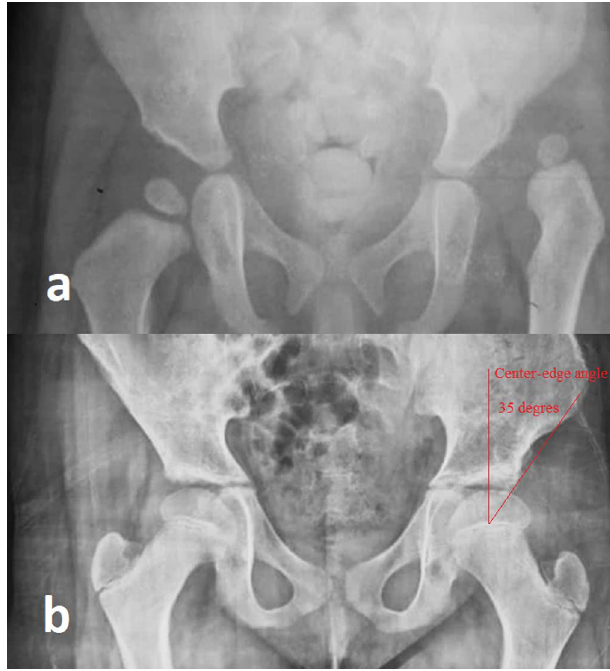
Figure 1. (a) Preoperative radiograph of a girl 1.5 years old of age with right DDH; (b) radiograph at the age of 8 with center-edge angle(CEA) of 35 (cid:1) (Severin score at I) at 6.5 years follow-up after open